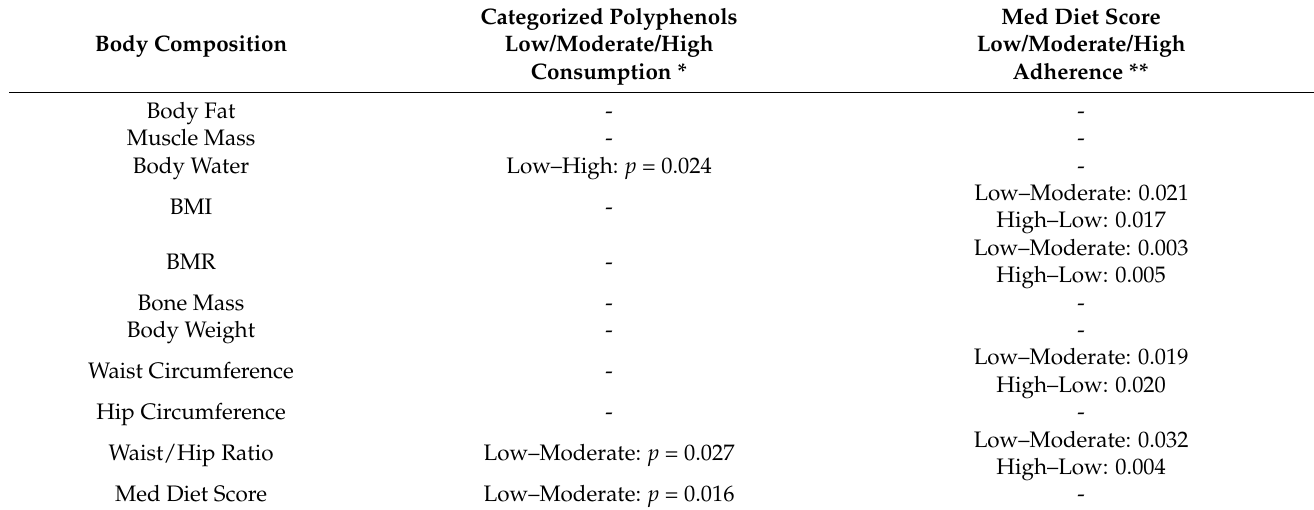
Table 3 present the association of anthropometric indices with low, moderate, or high polyphenol intake. Participants who were consuming low intakes of polyphenols (<1000 mg) appeared to have significantly increased body water content, in comparison with participants with high intakes (>2000 mg) ( p = 0.024). Moderate polyphenols’ intake (1000–2000 mg) was associated with significantly reduced waist-to-hip circumference, compared with low polyphenols’ intake ( p = 0.027). Furthermore, moderate adherence to the Mediterranean diet, correlated with significantly higher polyphenols intake in comparison with low adherence ( p = 0.016). Table 3. Association between polyphenols intake and Med Diet Score and body